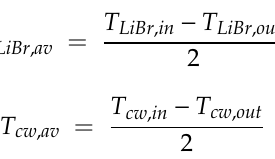
Figure 5. Theoretical versus experimental desorption rate.